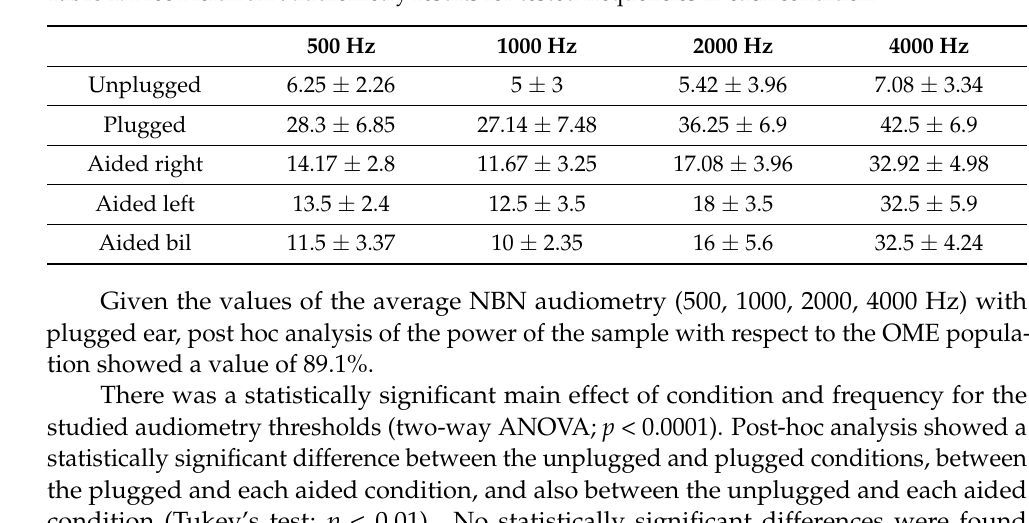
Figure 3. Average free-field threshold in each test condition. Mean value ± SD values are shown in Table 1. Table 1. Free Field NBN audiometry results for tested frequencies in each